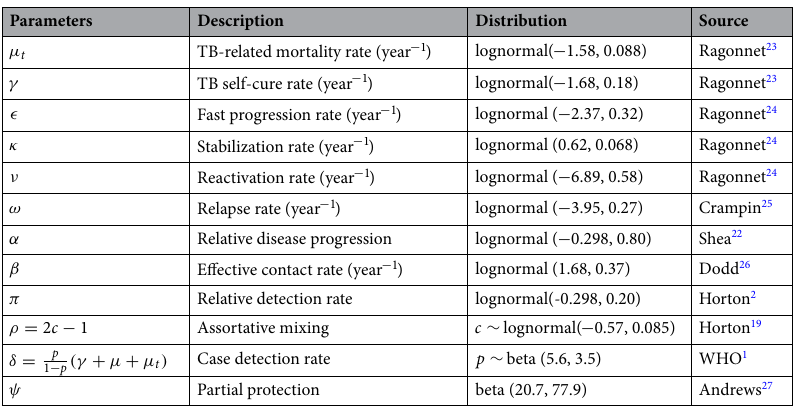
Table 1. Priors and sources for model parameters. NB the prior for δ is defined by comparison to competing hazard parameters to give an uninformative prior on the probability of a TB case being notified ( p ). The inference code implemented priors for the first ten parameters as truncated log-normal to ensure only positive values were considered. We chose the α prior so that the mid value is centered at 1.0 22 and increased the reported standard deviation to 1 to allow for greater differences in other